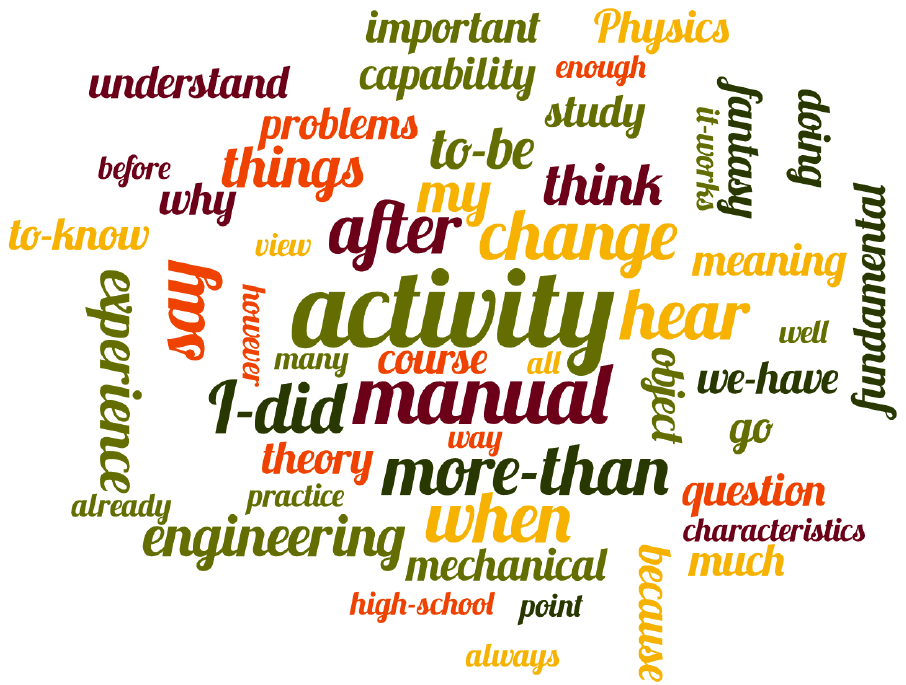
Figure 3. Most frequently mentioned words during